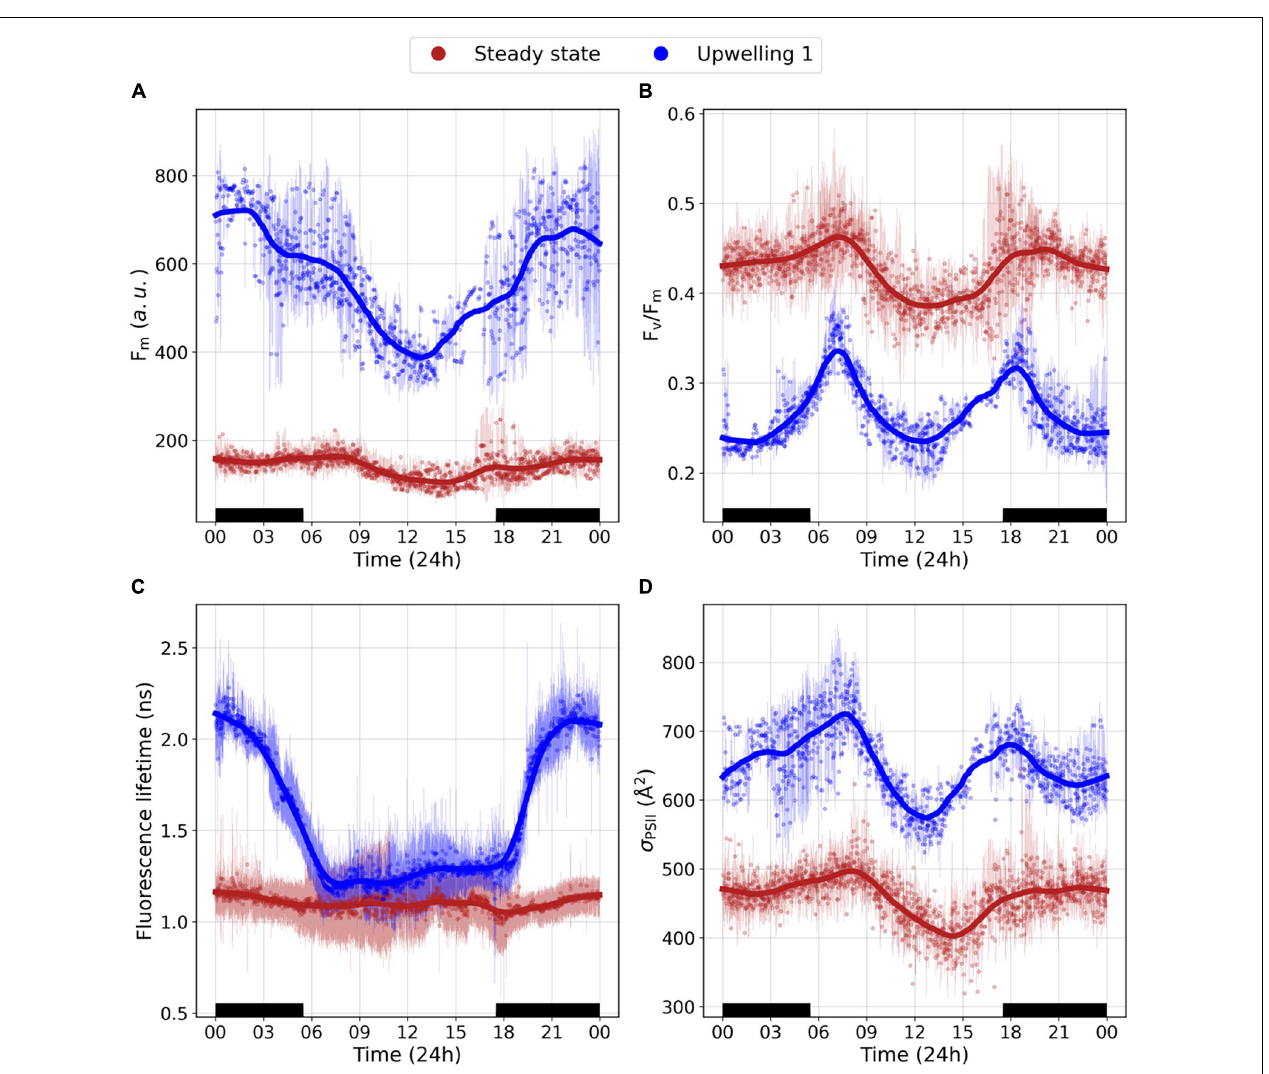
FIGURE 4 | Mean diel cycles in photophysiology. (A) F m , (B) F v /F m , (C) Fluorescence lifetime, and (D) σ PSII . Red dots represent the mean diel cycle averaged across the steady state section ( n = 17 days) and blue dots represent the mean diel cycle averaged across uw1 ( n = 5 days). Red and blue translucent lines denote the standard deviation. A lowess smoother was applied to each section’s mean diel cycle (red and blue